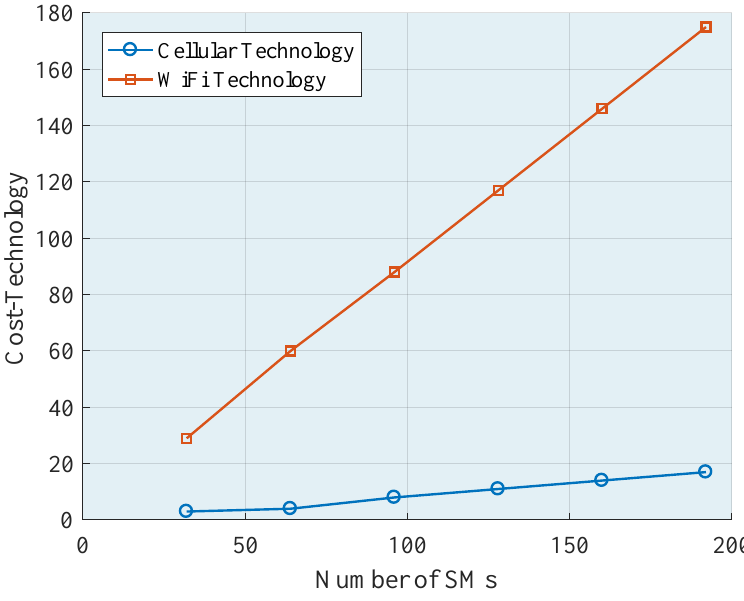
Figure 9. Cost by type of wireless